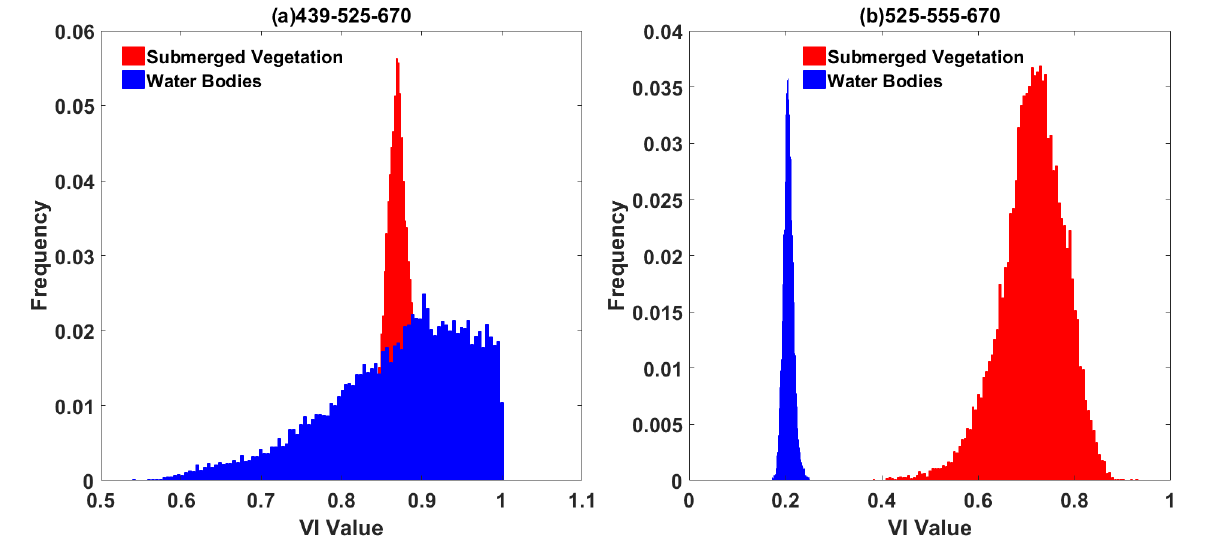
Figure 4. The frequency histograms of the angle indices for submerged vegetation (red) and water bodies (blue). (a) 439-525-670; (b)